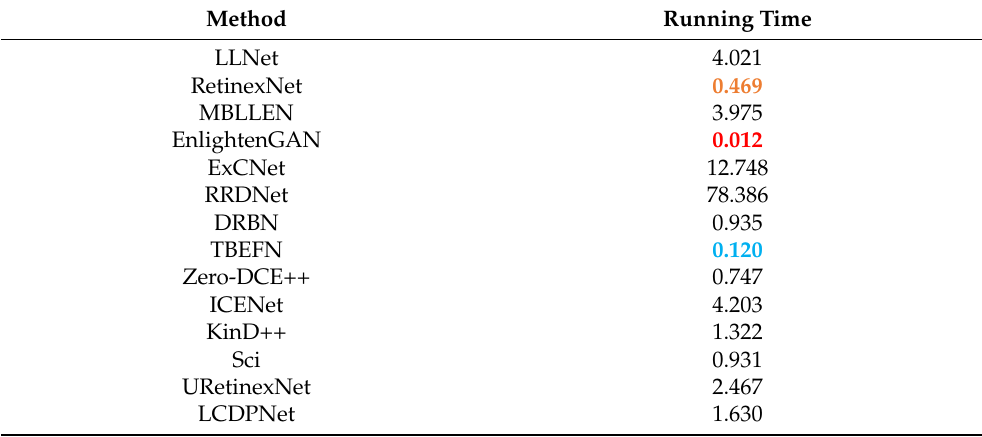
Table 8. Average running time (in seconds) of image enhancement in VE-LOL-H. The best result is bold in red , the second result is bold in blue , and the third result is bold in yellow .